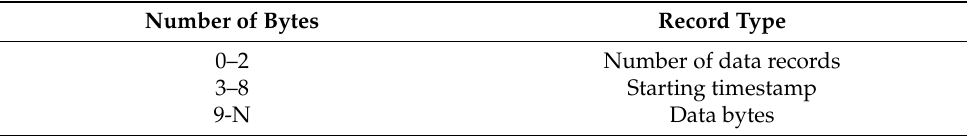
Table 1. EEPROM data